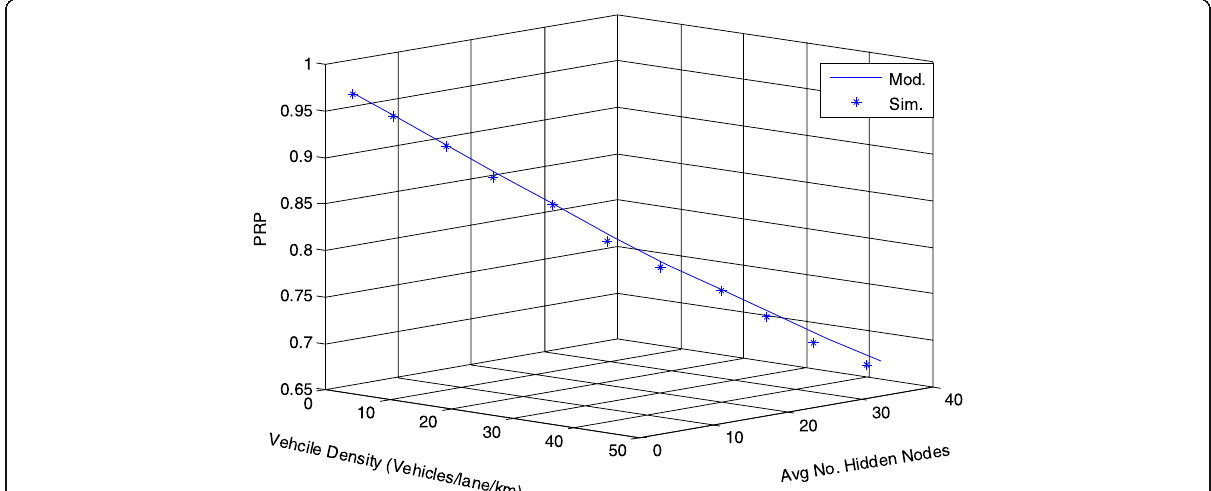
Fig. 10 PRP due to hidden terminal collisions with respect to vehicle density and average number of hidden nodes for analytical model and simulations, W 0 = 16, R = 6 Mbps, R c = 250 m, λ = 10 Hz, D = 186